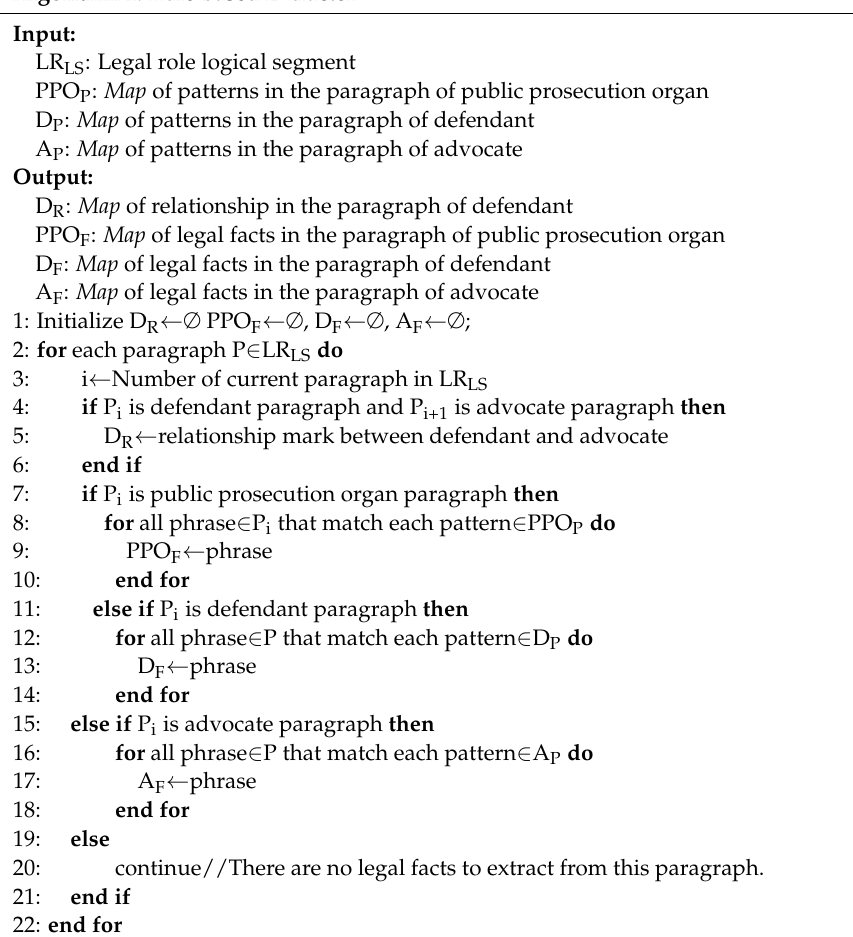
Algorithm 1. Rule-based